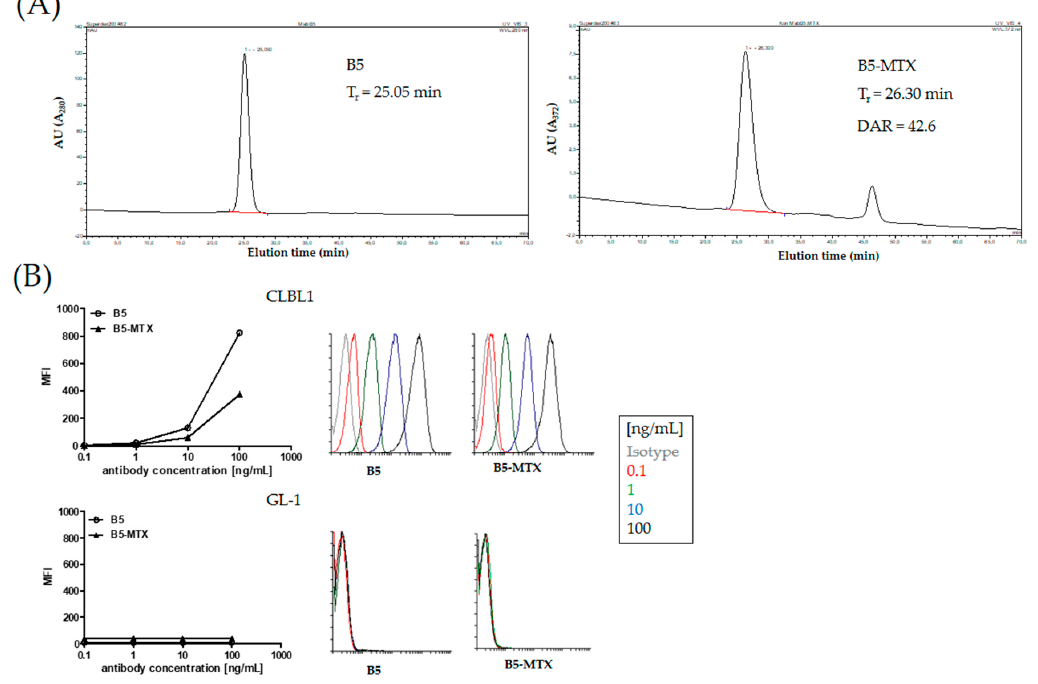
Figure 1. Synthesis of B5-MTX ADC. ( A ) Size-exclusion HPLC of unmodified mAb B5 (top),